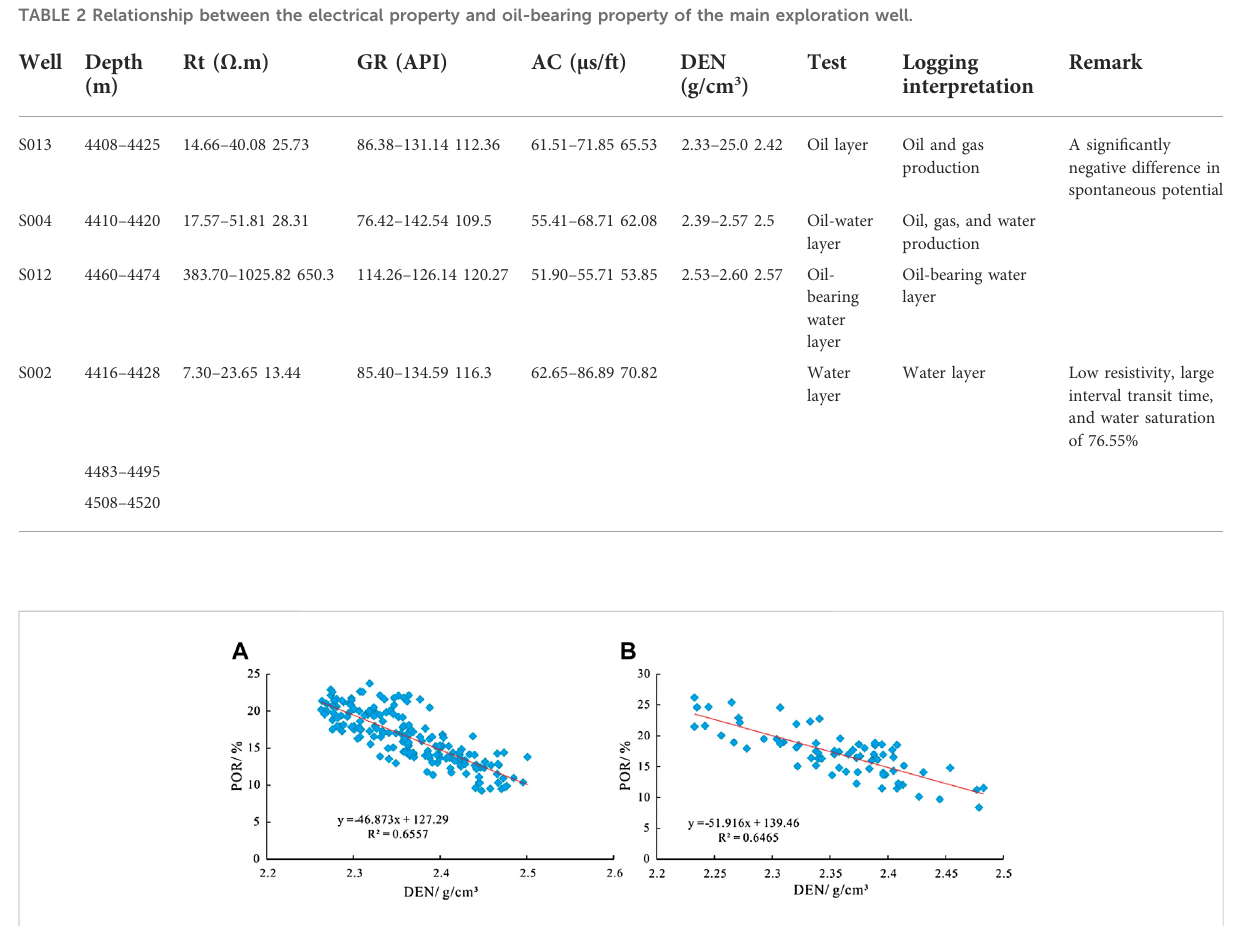
FIGURE 7 The relationship between porosity and density in the study area. (A) well S001; (B) well S005.